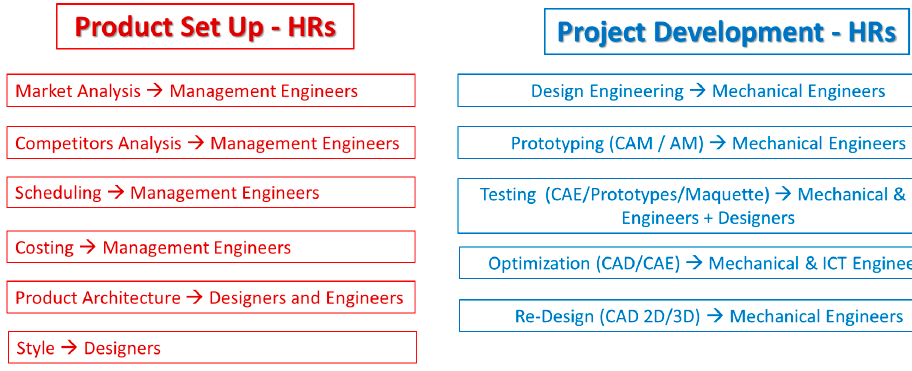
Figure 29. IDeS vs. specific skills for HR.